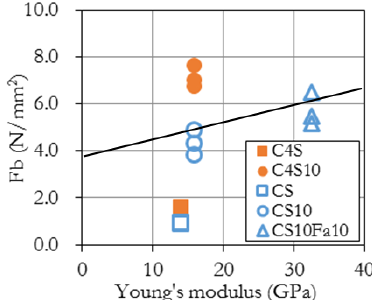
Figure 12: Experimental